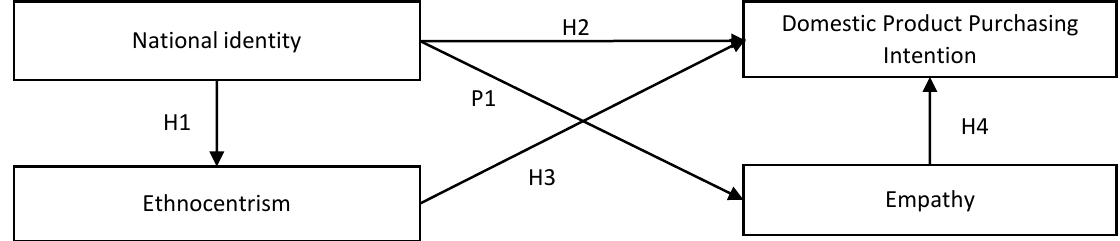
Figure 1. Conceptual